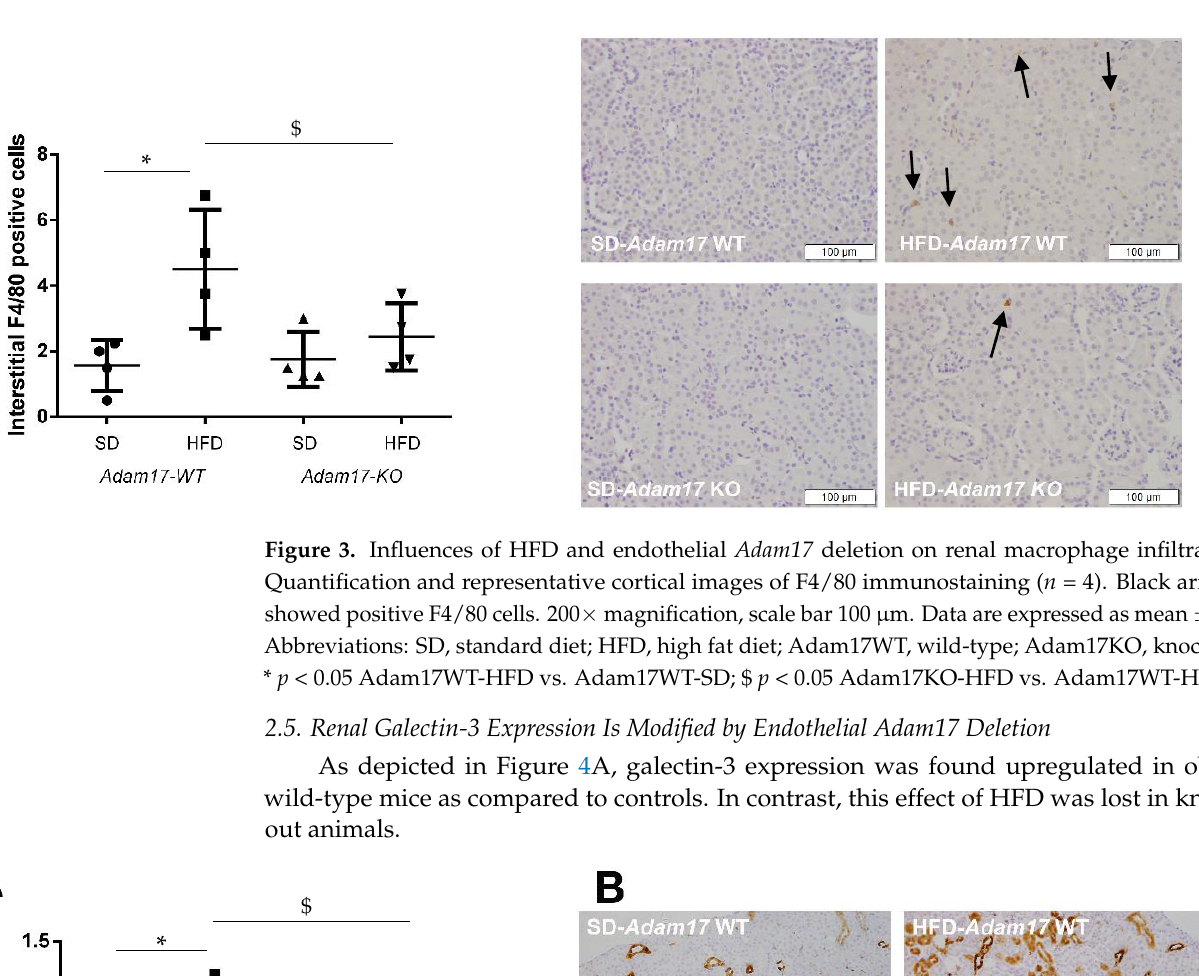
Figure 3. Influences of HFD and endothelial Adam17 deletion on renal macrophage infiltration. Quantification and representative cortical images of F4/80 immunostaining ( n = 4). Black arrows showed positive F4/80 cells. 200× magnification, scale bar 100 μ m. Data are expressed as mean ± SD.